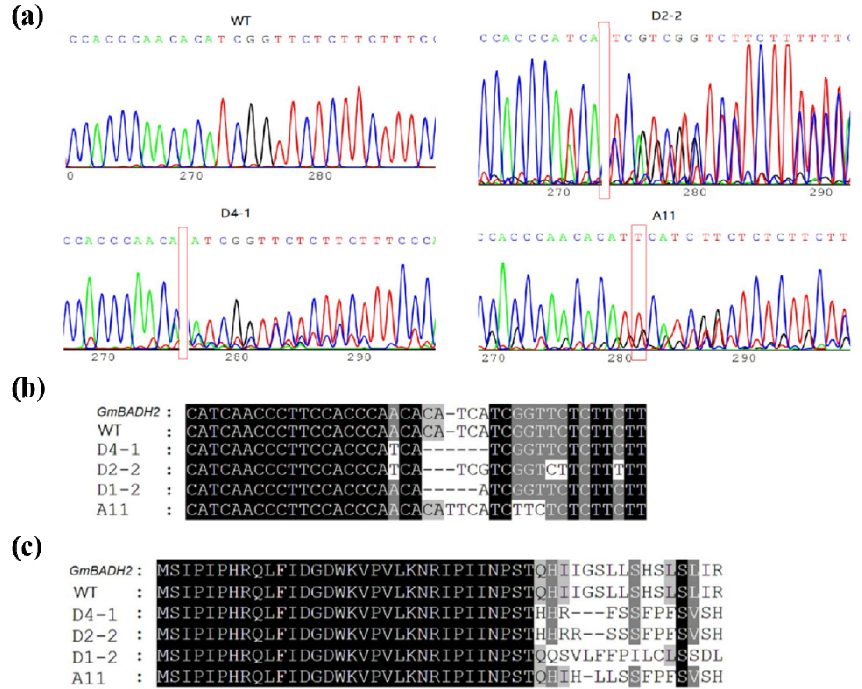
Figure 4. Mutations in T 0 and T 1 plants induced by sgRNA. ( a ) Sequencing peak plots of wild-type (WT) and T-DNA-positive T 0 lines. Red boxes indicate possible mutation sites. ( b ) Alignment of the GmBADH2 sequences of the T 1 mutant and WT lines. WT, Tianlong No. 1; GmBADH2 , Glyma05g01770. ( c ) Alignment of the GmBADH2 amino acid sequences of the T 1 mutant and WT lines.